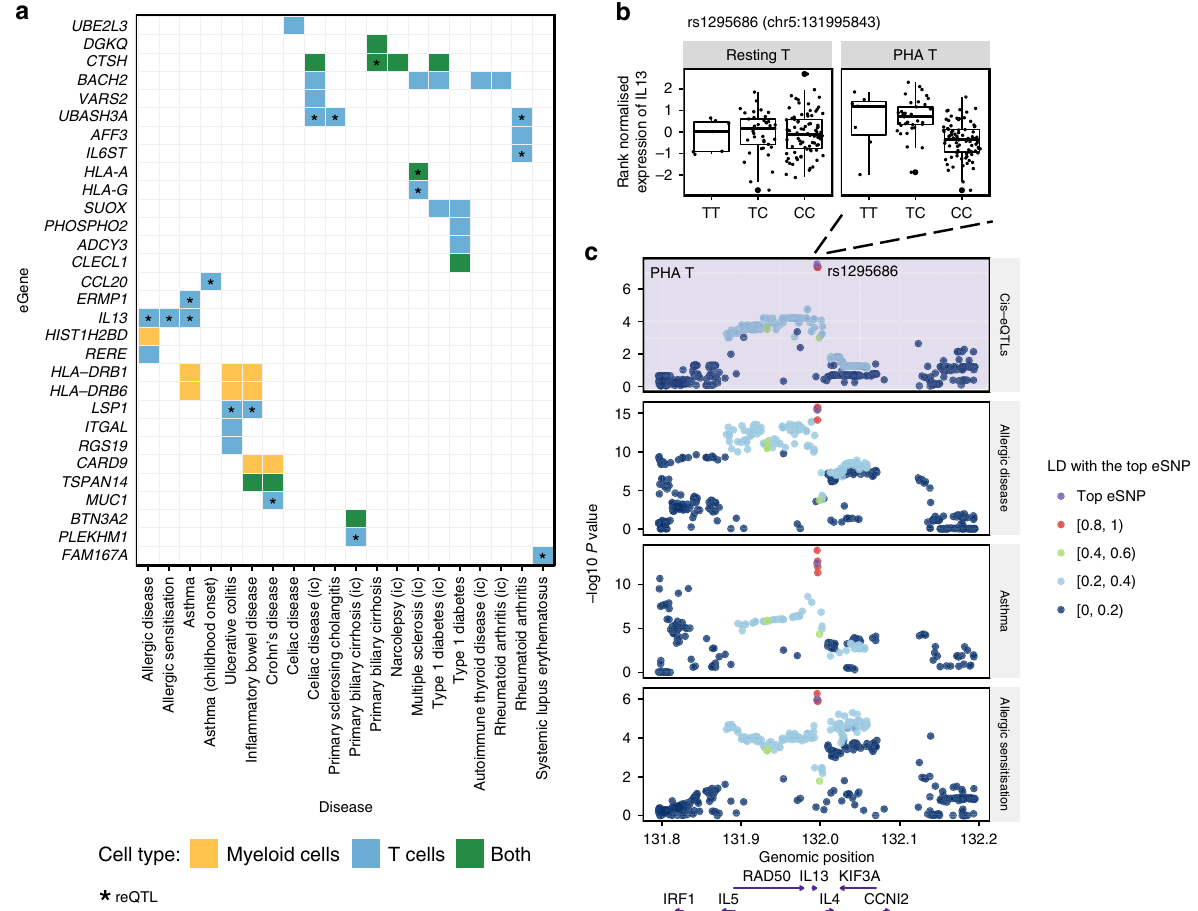
Fig. 4 Colocalisation of cis -eQTLs with disease associations. a A heatmap shows all cases with strong evidence of colocalisation between cis- eQTLs of corresponding genes (eGenes) in rows and GWAS hits associated with allergic and autoimmune diseases in columns (ic: the study was performed using ImmunoChip array). Colours indicate the cell type where the signi fi cant colocalisation was observed. Asterisks indicate that the colocalised eQTLs are response eQTLs (reQTLs). b Boxplots show the rank-normalised gene expression of IL13 ( y -axes) in resting T cells (left) and in PHA-stimulated T cells (right) strati fi ed by genotypes of the reQTL rs1295686 (x-axes), the top eSNP in PHA-stimulated T cells. The centre line corresponds to median, and lower and upper hinges indicate the 25th and 75th percentiles. The upper whisker extends from the hinge to the largest value ≤ 1.5 * inter-quartile range (IQR) from the hinge, and the lower whisker extends from the hinge to the smallest value at most 1.5 * IQR of the hinge. The highest and lowest dots show the maximum and minimum gene expression. In resting T cells, no SNP was signi fi cantly associated with IL13 . c Regional plots show eQTL association with gene expression of IL13 in PHA-stimulated T cells (purple background), and GWAS associations with allergic disease (asthma, hay fever, or eczema), asthma, and allergic sensitisation. The minus log10 P -value is plotted on y -axes for all SNPs located within 200 kb from the top eSNP of IL13 . Colours of dots indicate the LD correlation with the top eSNP (in purple). Positions of genes located on this locus are shown at the